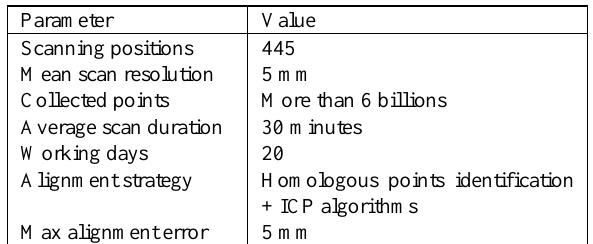
Table 4. Detailed information about the laser scanning survey as performed in the St. Stefano Basilica in 2012.